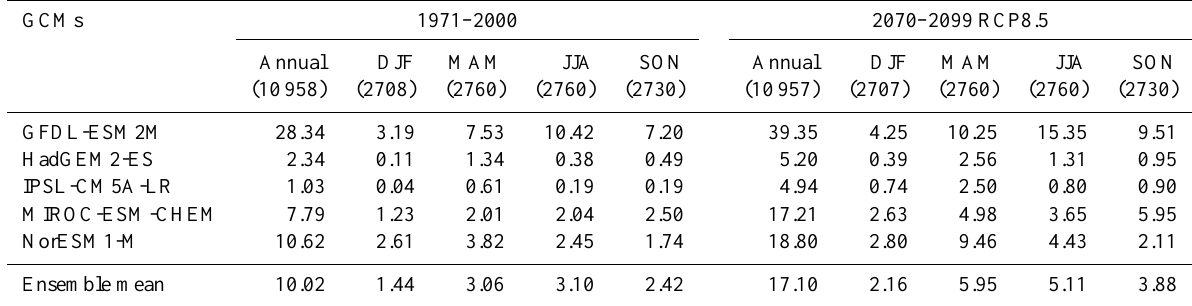
Table 2c. Total number of days when the humidity is truncated at 0%RH during adjustment by our primitive bias correction described in Sect. 2.4.2. Both the annual and seasonal sums are given by the mean over all land cells (67420 cells). The total numbers of days are given in parentheses in the header.